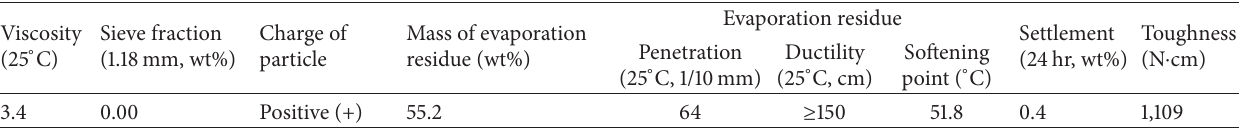
Table 4: Modified emulsified asphalt HS-S ⋅ P COAT properties.